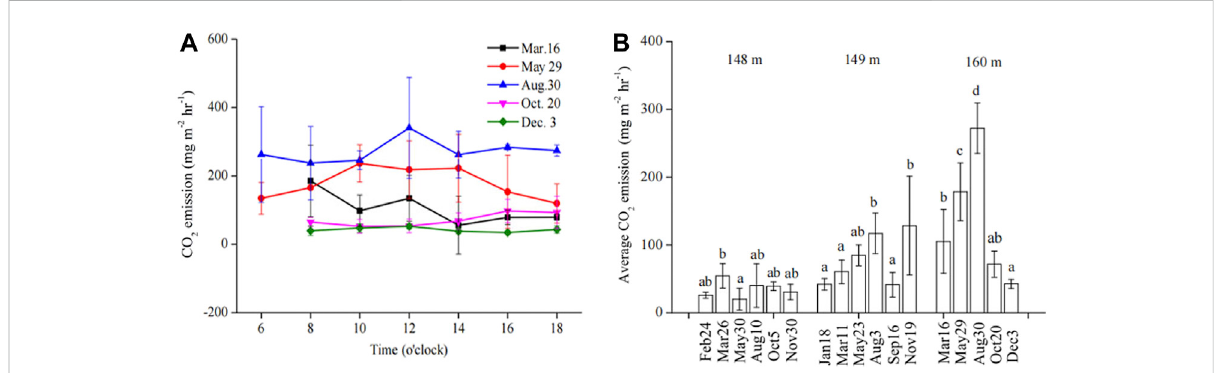
FIGURE 2 Dynamic variation of CO 2 fl ux at the 160 m plot of Zigui during the daytime (A) and the average CO 2 fl ux at 148 m, 149 and 160 m elevations of Zigui during thedaytime (B) . Note: The plotat160 m wasdrainedon March 16,May29, and August 30. Different letters within thesame plotindicate the signi fi cant difference at the level of p =